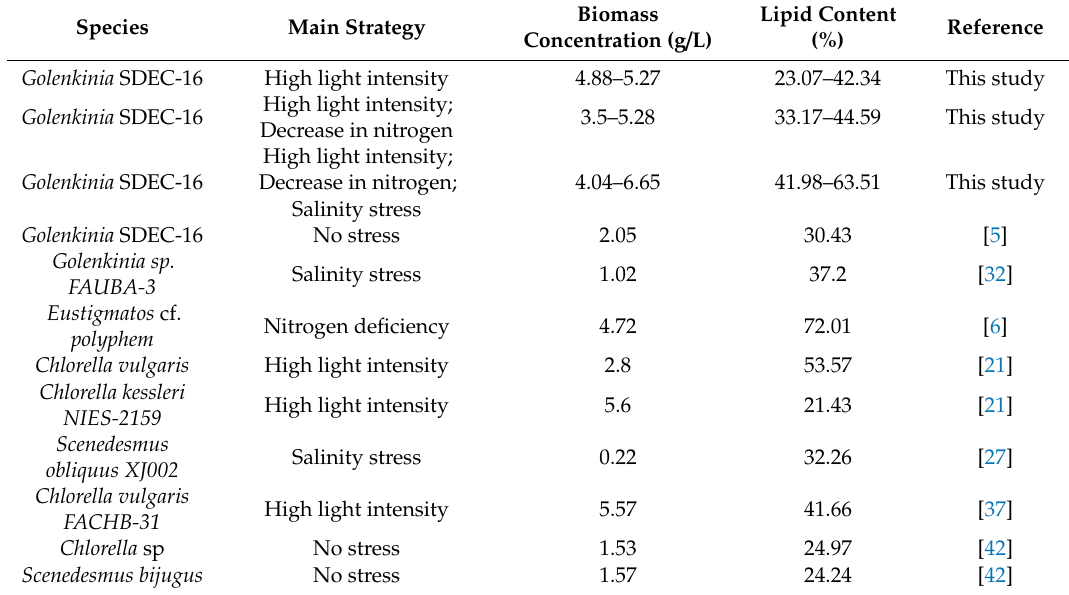
Table 1. Comparison of the biomass concentrations and lipid contents in Golenkinia SDEC-16 with published results.